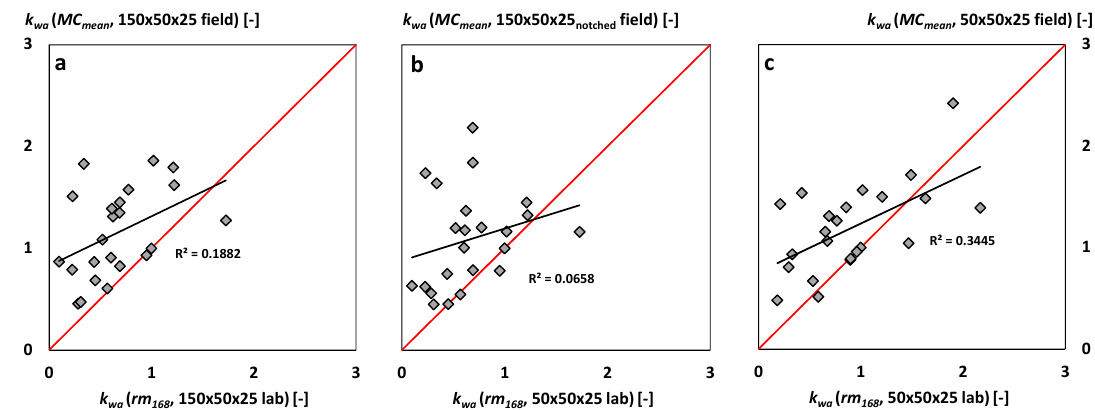
Figure 6. k wa factors based on MC mean (%) measured during outdoor exposure versus k wa factors of rm 168 ( a – c ) in grams determined in submersion ( a , b ) and floating tests ( c ) according to [5].